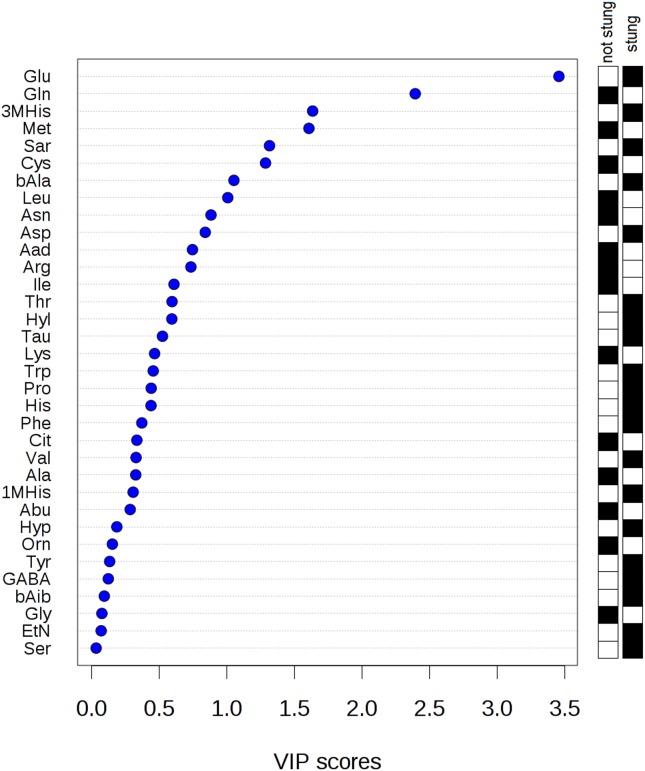
Variable importance in projection (VIP) plot: important features (analyzed serum free amino acids) identified by PLS-DA in a descending order of importance.The graph represents relative contribution of amino acids to the variance between the stung and non-stung individuals. High value of VIP score indicates great contribution of the amino acids to the group separation. The black and white boxes on the right indicate whether the metabolite concentration is increased (black) or decreased (white) in the serum of the stung vs. non-stung beekeepers.